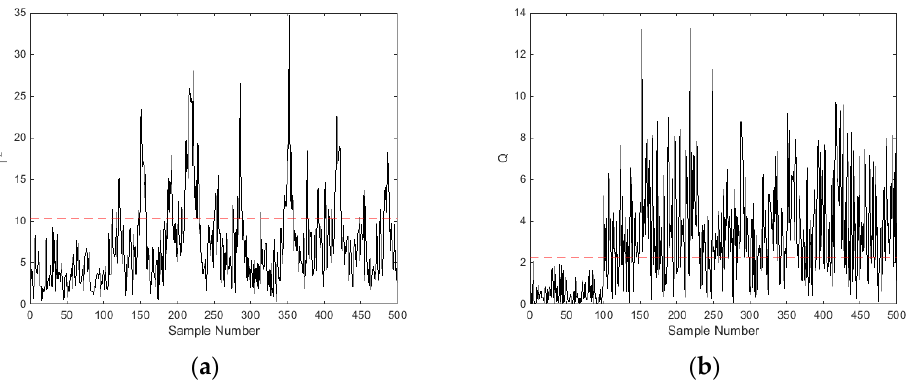
Figure 4. Monitoring charts of oil filter clogging by using multivariate statistics (75% full load and 1800 rpm): ( a ) Hotelling 2 T at different samples and ( b ) Q statistic at different samples.